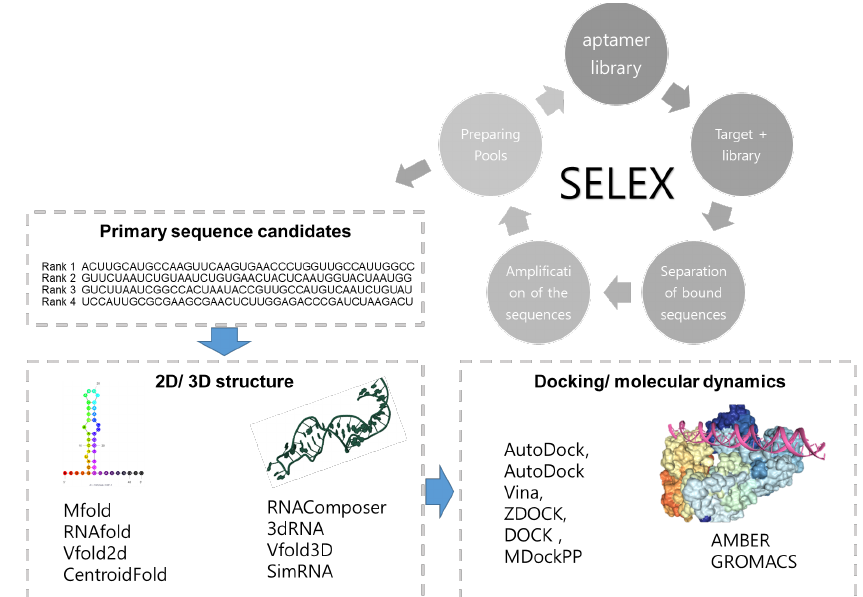
Figure 1. In silico design of aptamer.